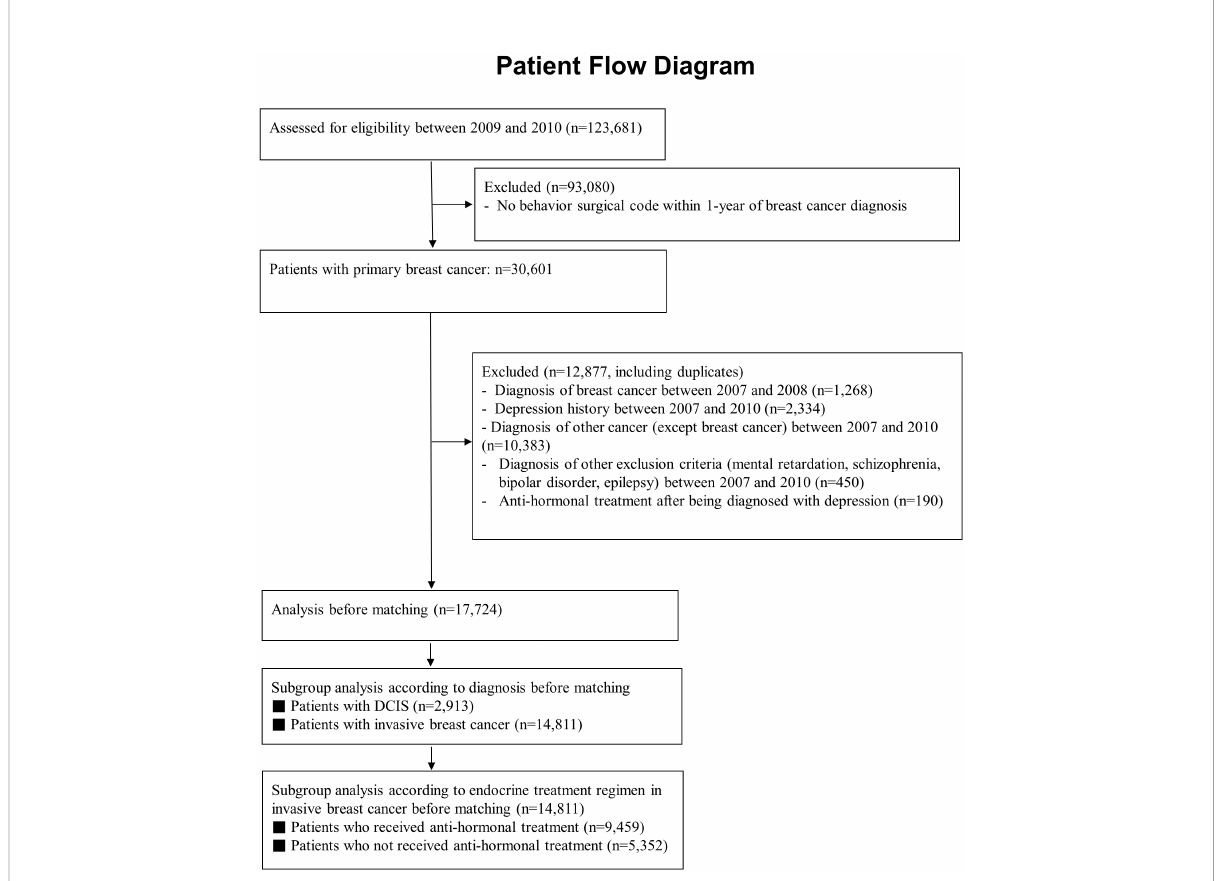
FIGURE 1 Flow diagram for the selection and enrollment of eligible patients in this